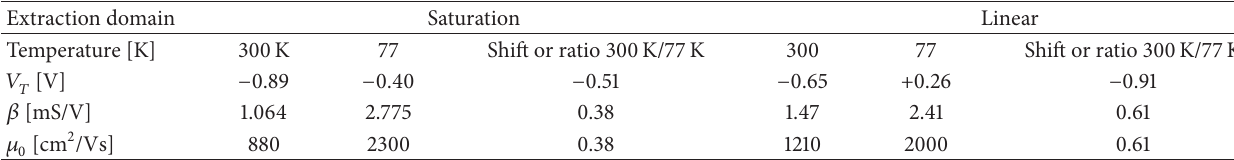
Table 3: Comparative table of the threshold voltage 𝑉 𝑇 , 𝛽 parameter, and mobility 𝜇 0 extracted from saturation and linear method [4] at 300 K and 77 K, respectively, for UTB device ( 𝑊/𝐿 = 80 𝜇 m/8 𝜇 m).